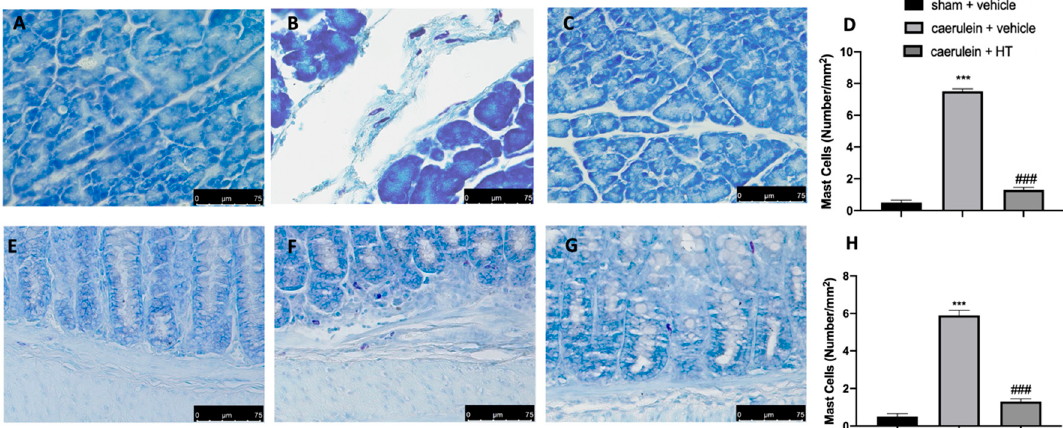
Figure 6. Hydroxytyrosol (HT) e ff ect on mast cell infiltration: toluidine blue staining of pancreas tissue: sham + vehicle ( A ), caerulein + vehicle ( B ), caerulein + HT (5 mg / kg) ( C ), mast cell count ( D ), toluidine blue staining of colon tissue: sham + vehicle ( E ), caerulein + vehicle ( F ), caerulein + HT (5 mg / kg) ( G ), mast cell count ( H ). For the analyses, n = 5 animals from each group were employed. A p -value < 0.05 was considered significant. *** p < 0.001 vs. sham + vehicle, ### p < 0.001 vs. caerulein + vehicle.